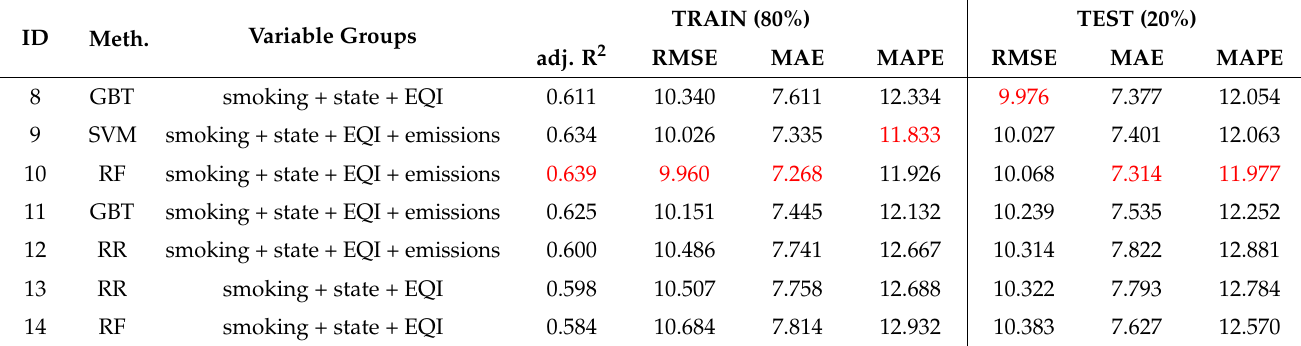
Table 6. RF: Random Forest, GBT: Gradient Boosted Tree; RR = Ridge Regression; SVM = Support Vector Machine; RMSE: Root Mean Squared Error; MAE: Mean Absolute Error; MAPE: Mean Absolute Percentage Error. ID